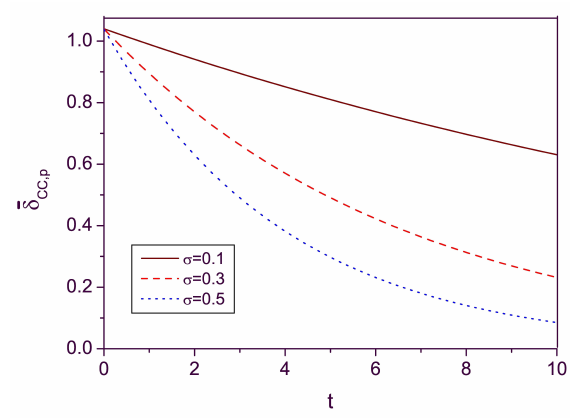
Figure 3: Time evolution of the MDACC in q -space given in Eq. (17), for three different values of σ . We used (cid:126) = 1 , ω = 1 , (cid:15) = 1 , and β = 1 .